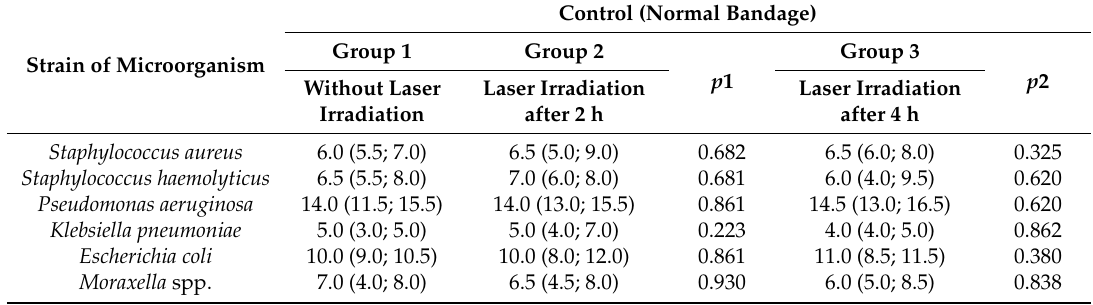
Table 5. The number of CFU of the investigated microorganisms along the edge of the ordinary medical gauze bandage (Me (Q 1 ; Q 3 )) and p —the level of statistical significance between groups.